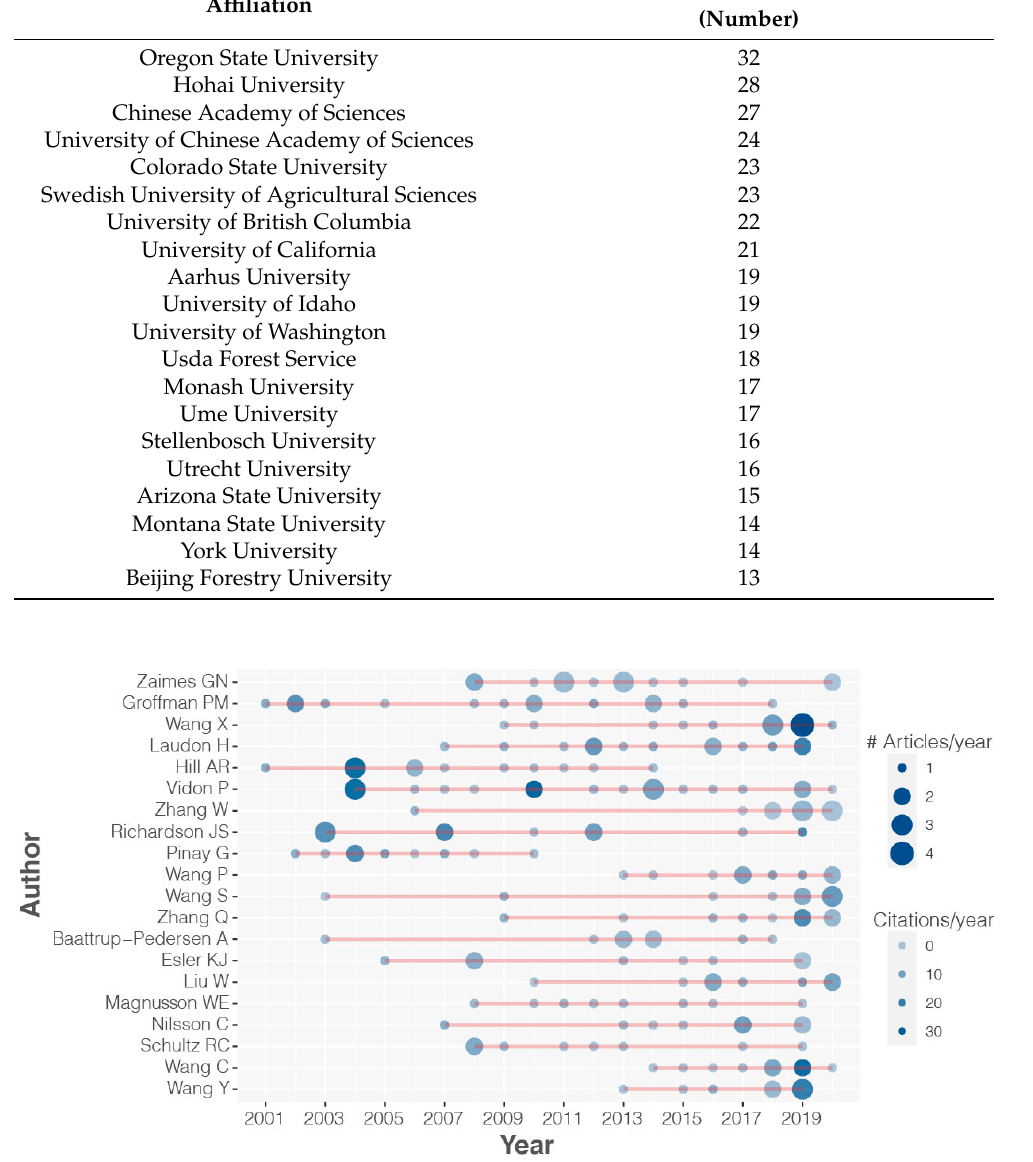
Figure 4. Most productive authors working on riparian zones (2001–2020).